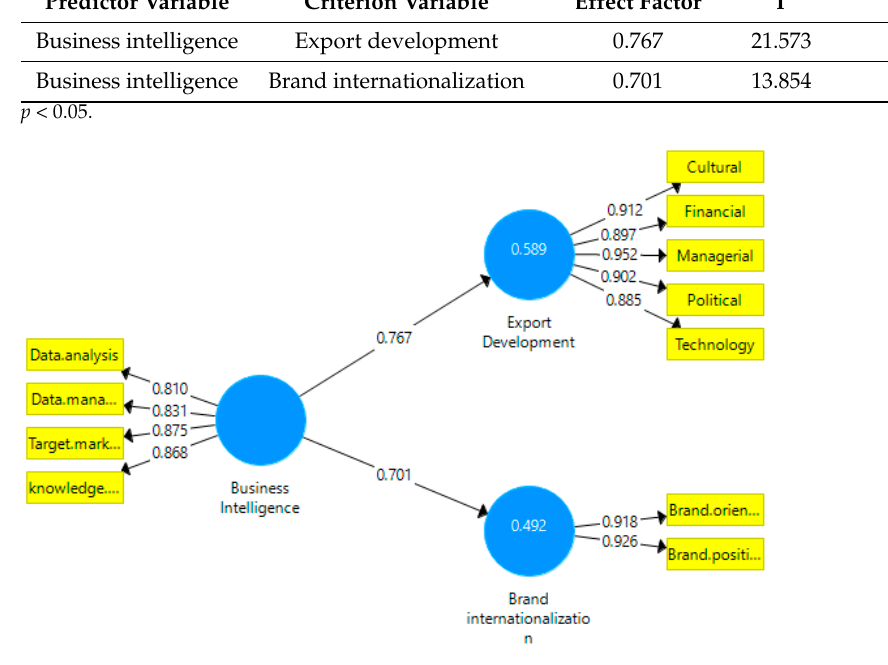
Figure 2. Coefficients for the effect of applying business intelligence on export development and brand internationalization in large industrial firms.